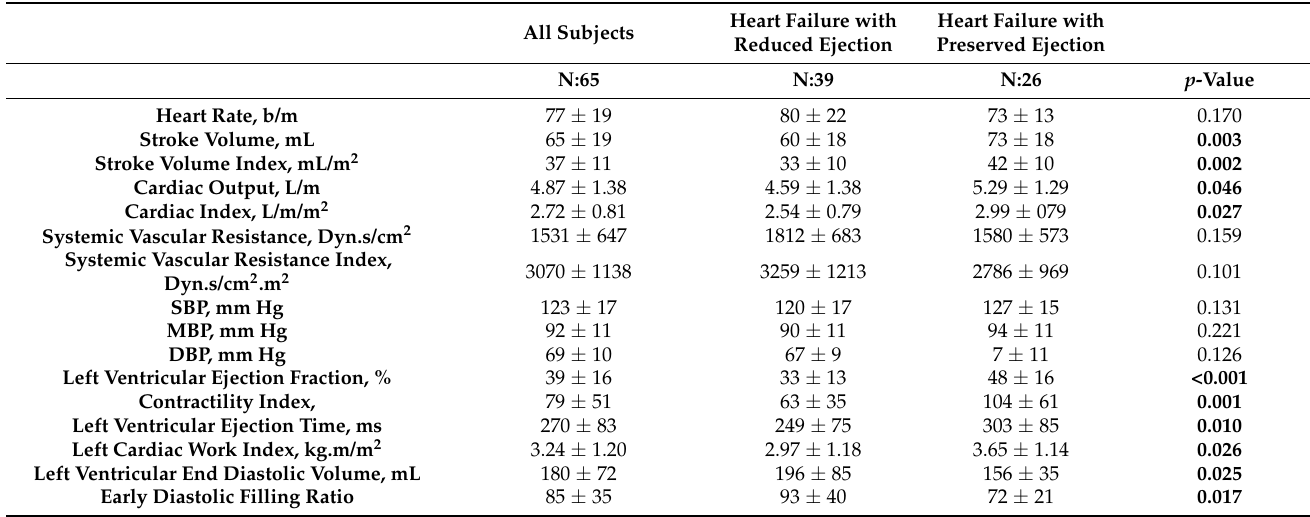
Table 2. Baseline Hemodynamic Data Obtained by Means of Bioimpedance.